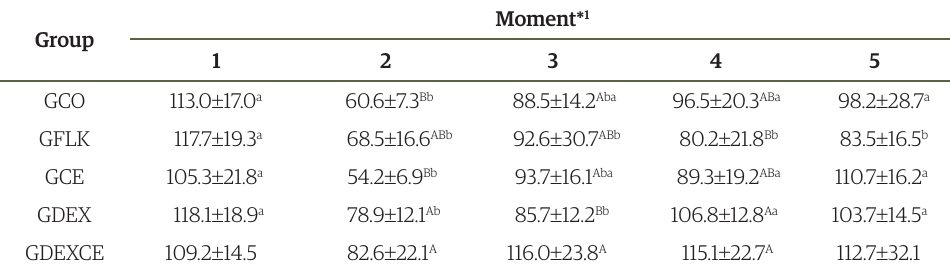
Table 3. Mean arterial pressure (MAP) values between moments in the groups.